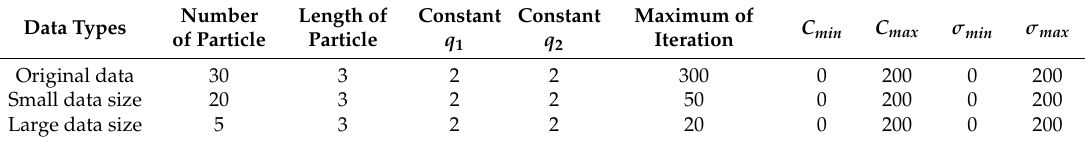
Table 2. The SVR-PSO’s parameters for Data-I (Example 1).